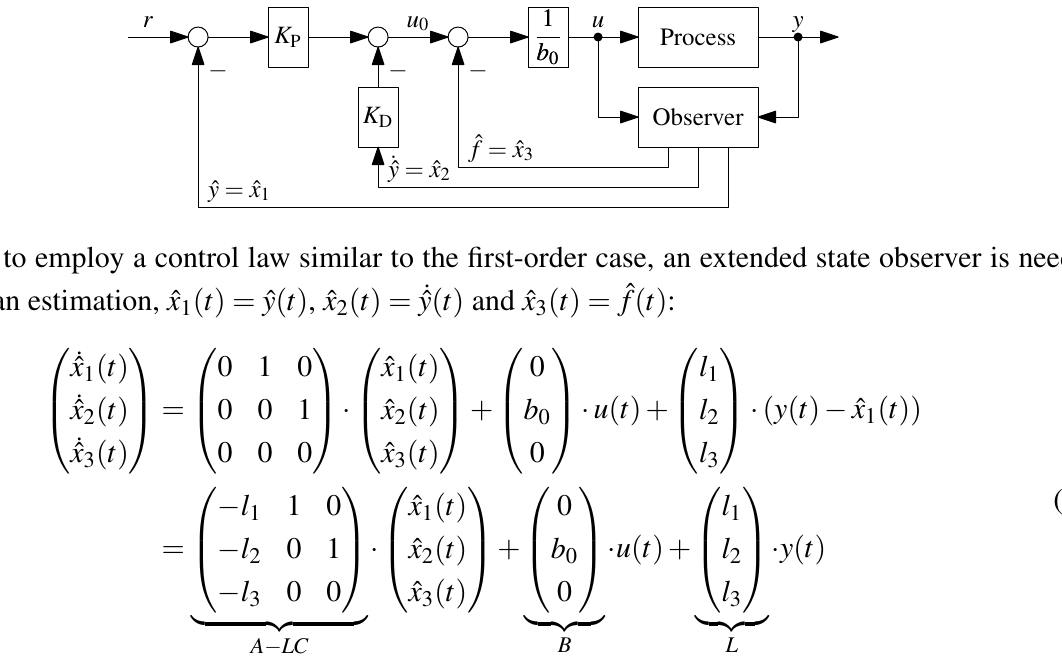
Figure 2. Control loop structure with active disturbance rejection control (ADRC) for a second-order